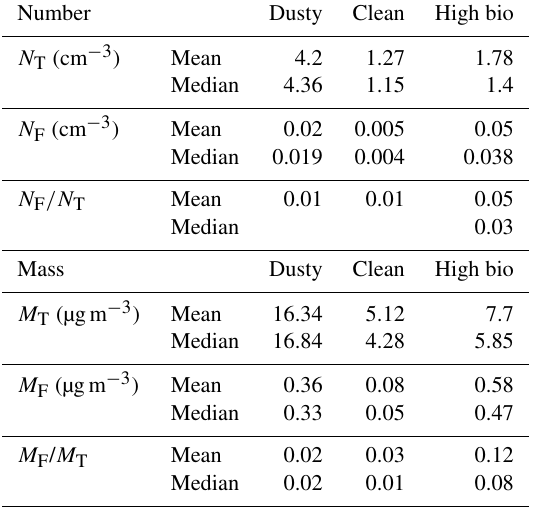
Table 4. Integrated number concentrations and mass concentrations of coarse TAP and FBAP ( ∼ 1–20µm): arithmetic mean and median for each focus period (dusty, clean and high